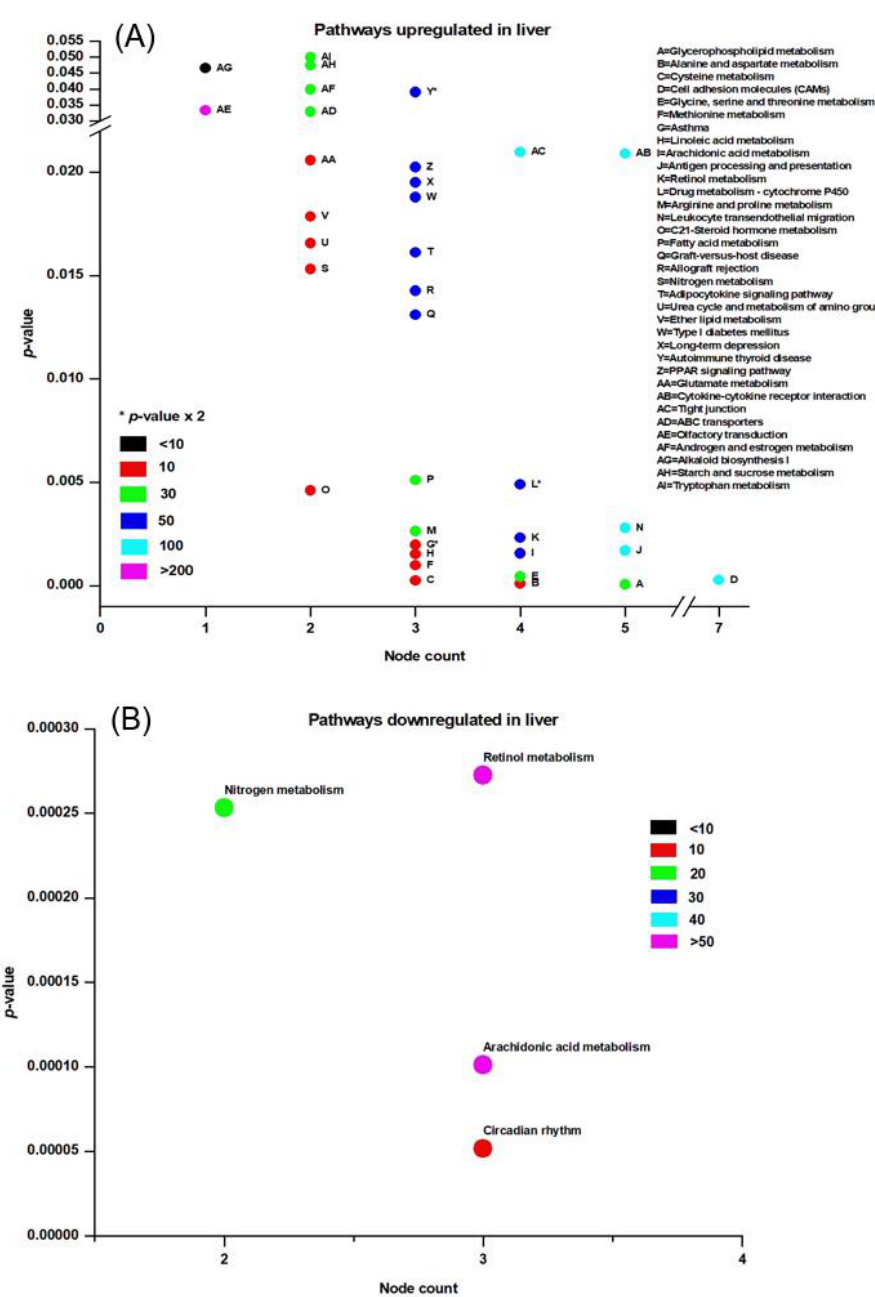
Figure 7. KEGG pathways affected by rapid eye movement sleep deprivation in rats in the liver: ( A ) up-regulated, ( B ) down-regulated. The x -axis depicts the number of nodes affected and the y -axis shows the * p -value ( p < 0.05). Color coding reflects the total number of associated nodes.